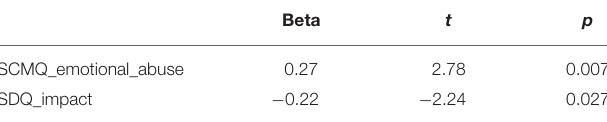
TABLE 4 | Emotional abuse and higher impact on SDQ scale as predictors of alcohol and substance use.